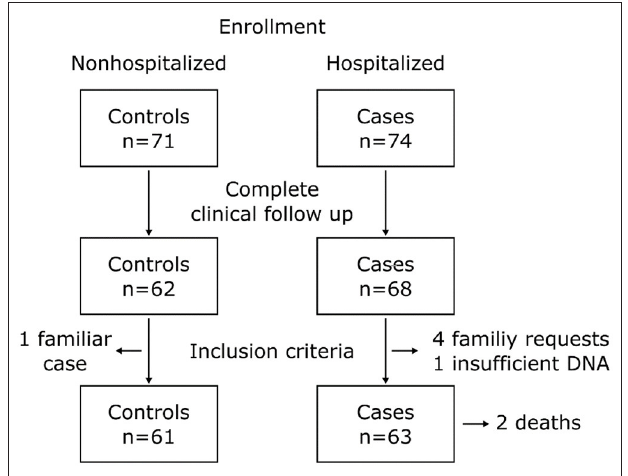
FIGURE 1 | Flowchart of the study participants.